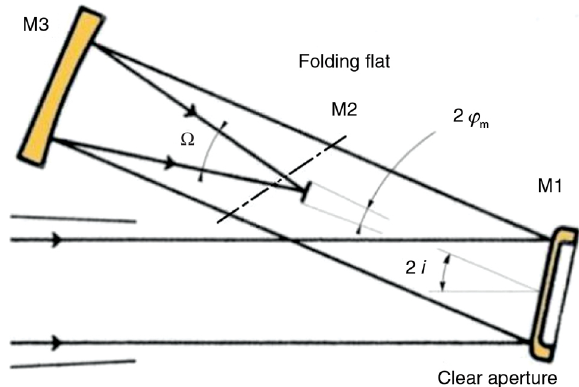
Figure 14: Schematic of Messier reflective Schmidt (M2 holed flat not shown).